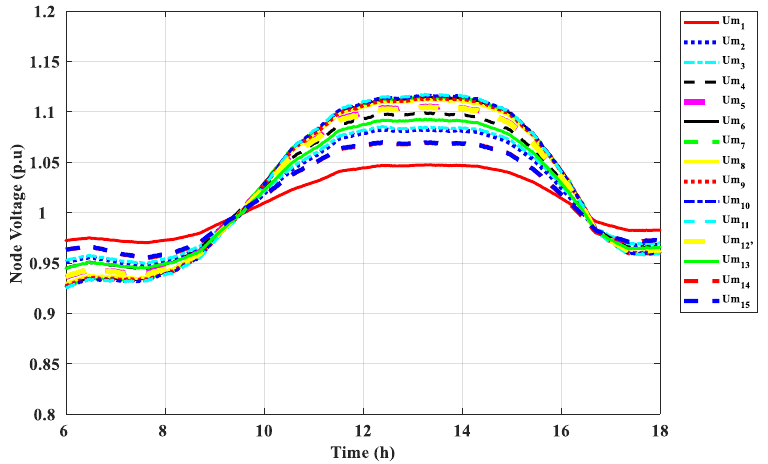
Figure 13. The voltage situation with centralized control when the central agent malfunctions.